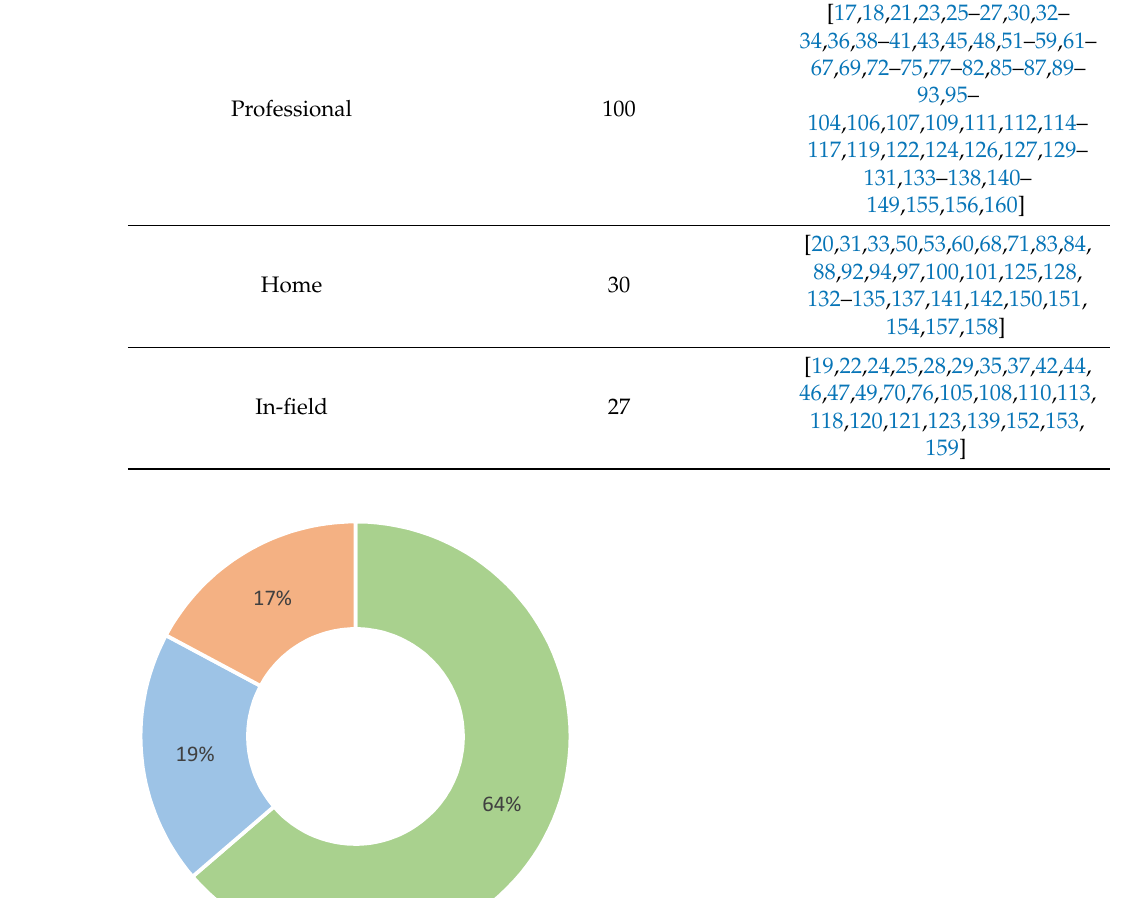
Figure 13. BMF applications prevalence according to the primary user. Table 10. Intended BMF application use environment.